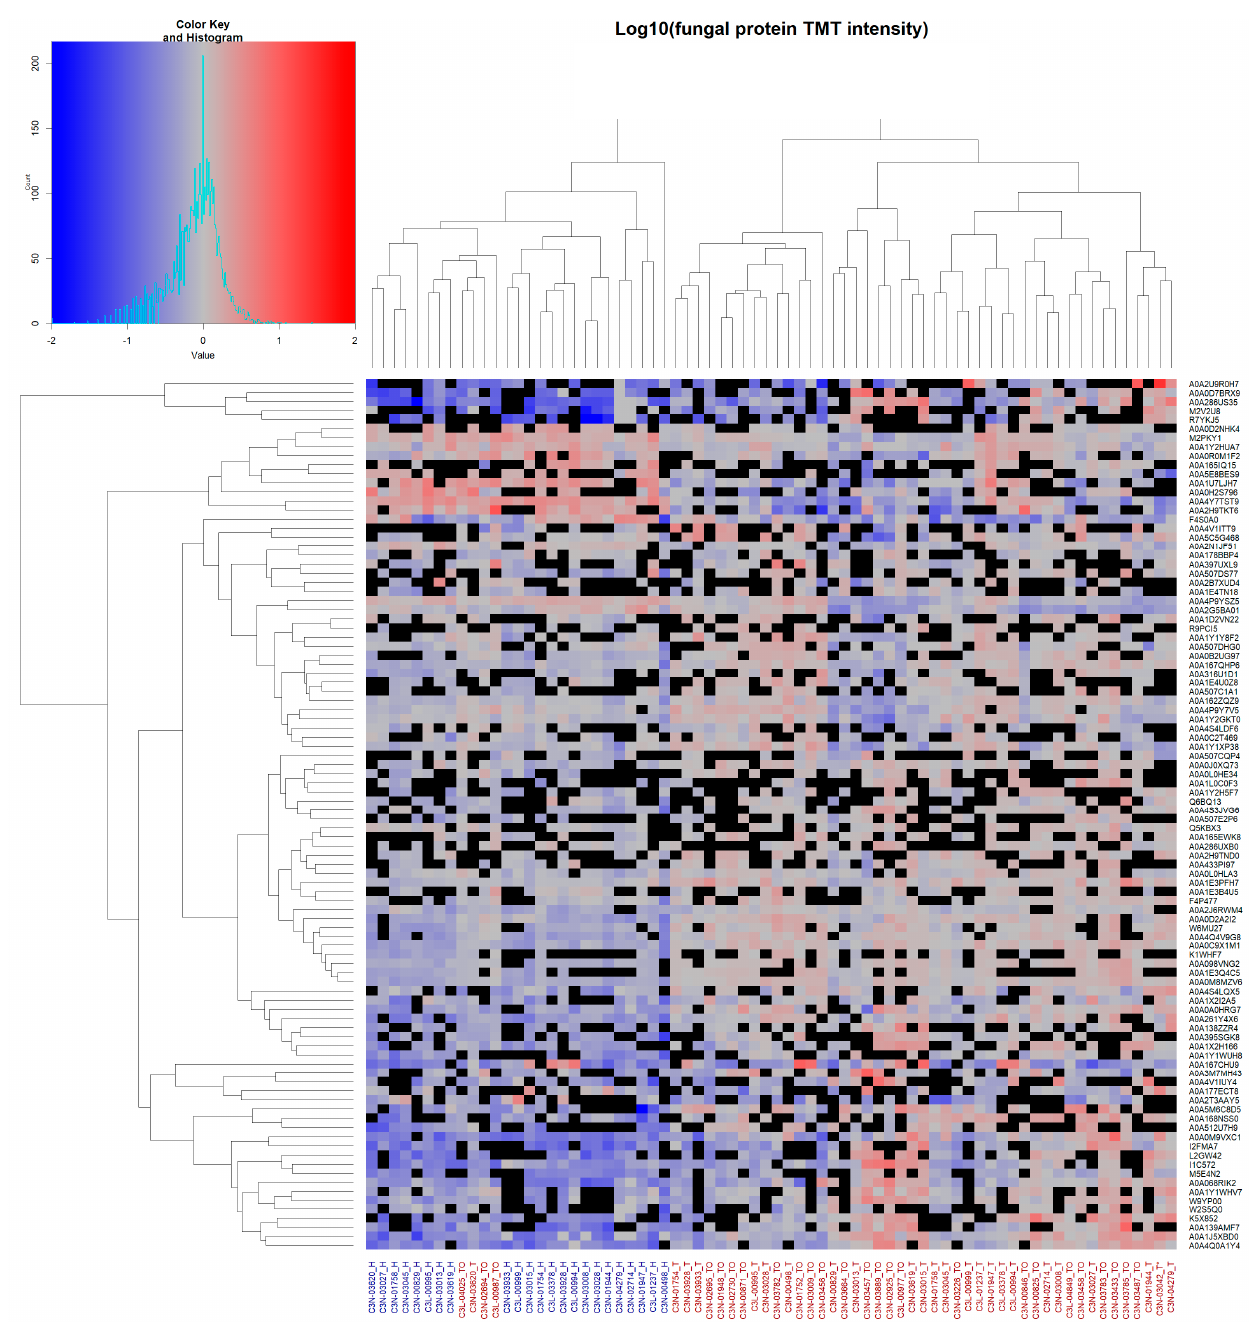
Figure 4. Unsupervised hierarchical clustering of fungal protein data: Unsupervised clustering of fungal proteins observed in ≥ 24 total patient samples. Complete linkage clustering was used with Euclidean distance measures. Cells show log10-normalised TMT-label intensity with blue and red indicating reduced and increased intensity, respectively, relative to the experimental reference sample. Black cells indicate missing values. Column labels represent either healthy NAT (blue labels) or tumour OSCC (red labels) patient samples. Protein UniProt accession numbers are shown for each row.